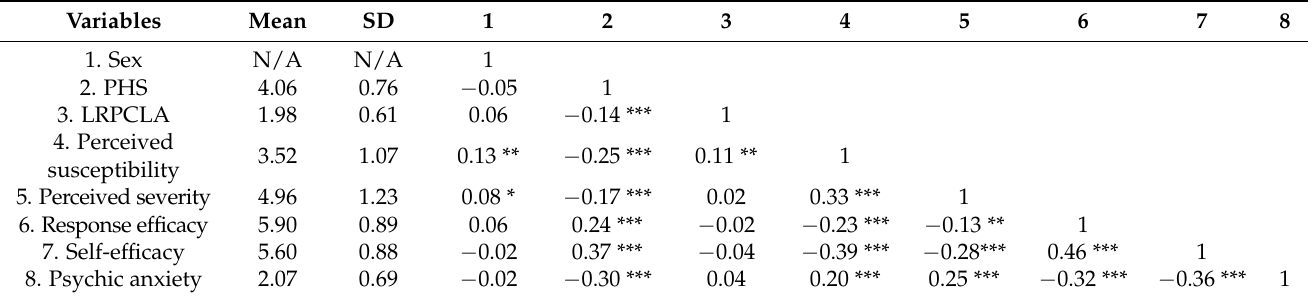
Table 1. Mean, standard deviation, and correlations.